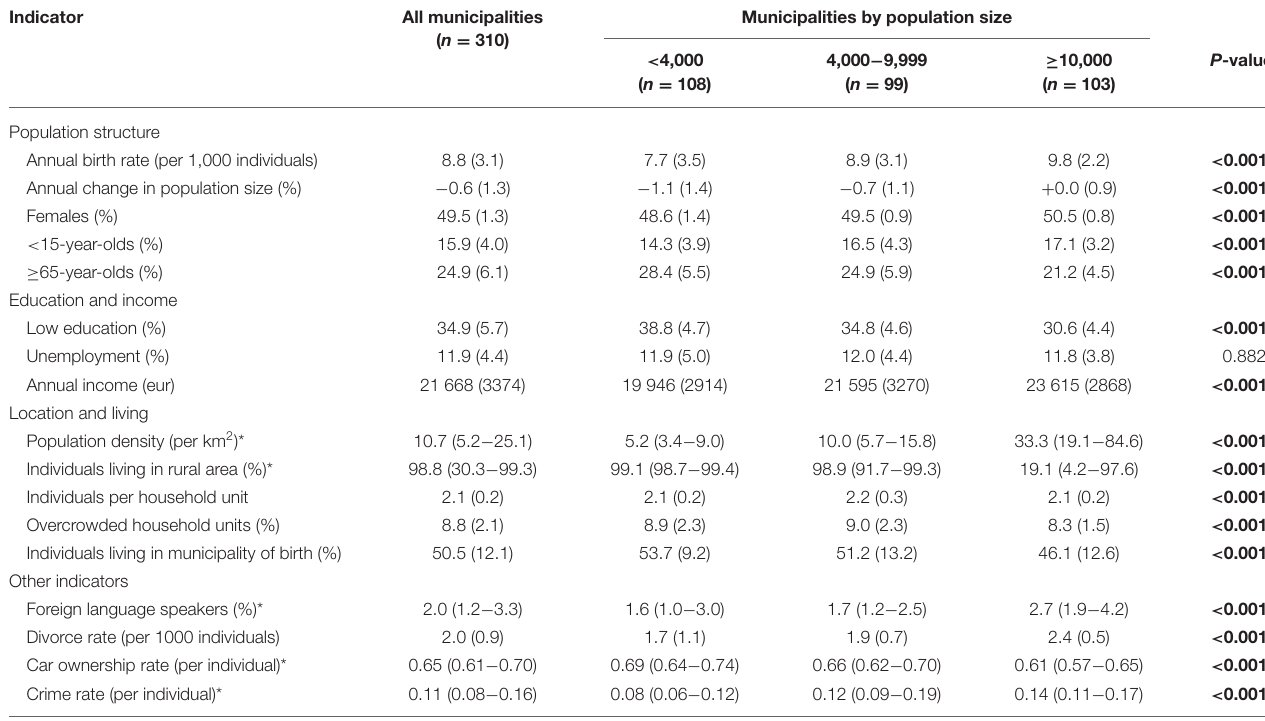
TABLE 1 | Characteristics of the Finnish municipalities in 2011–2018.